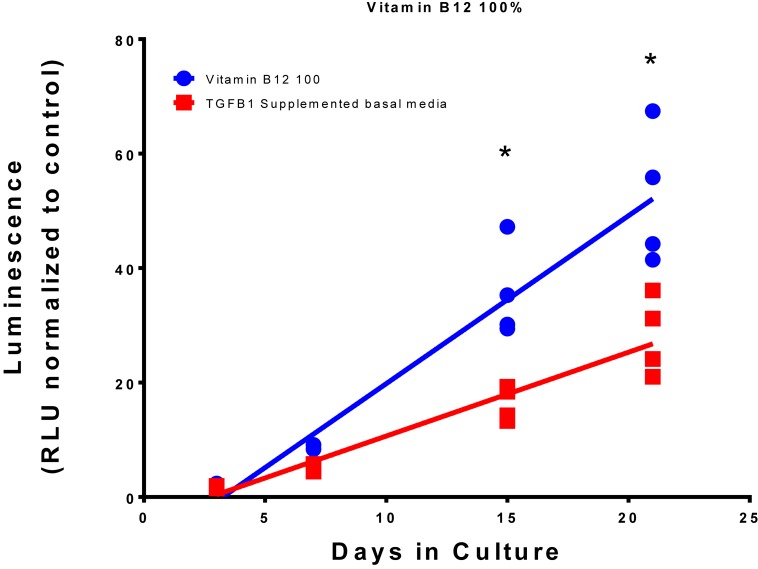
Comparison of Vitamin B12 and TGFβ1 supplemented medium with TGFβ1 supplemented basal medium. Type II collagen promoter-driven luminescence was assessed from the conditioned media and normalized to the plate basal medium control. Lines indicate a linear regression; symbols indicate individual data points. The symbol “*” significant difference vs. TGFβ1 supplemented basal medium; two-way ANOVA p < 0.05 Sidak’s multiple comparison test.